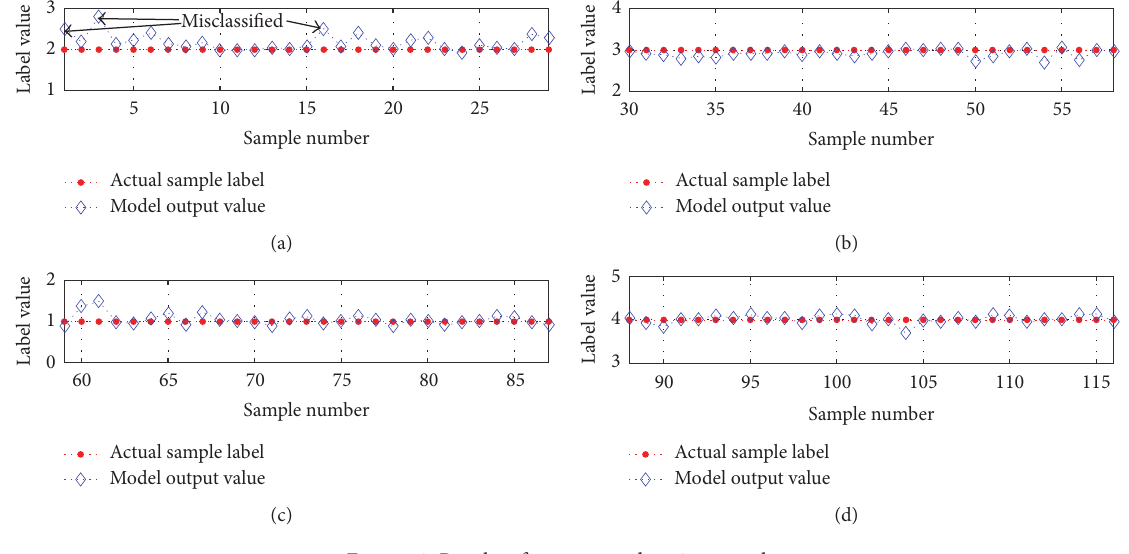
Figure 9: Results of unprocessed testing